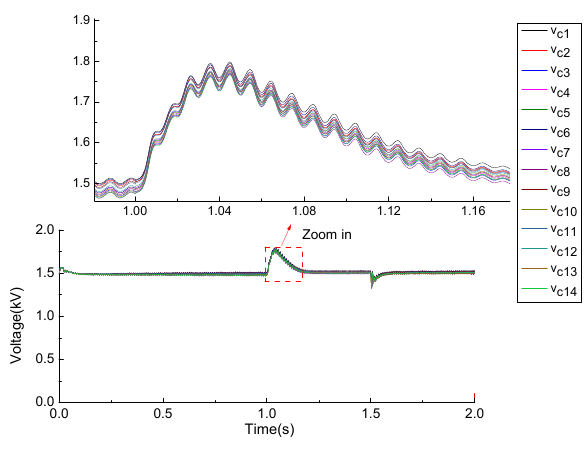
Figure 18. Module voltage waveform of branch-au.